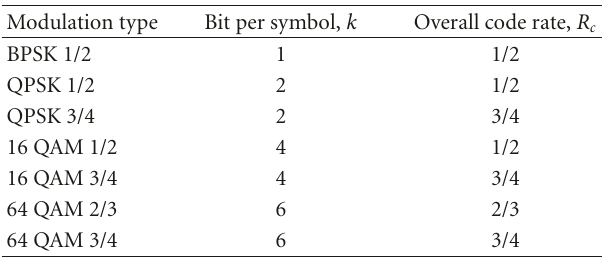
Table 4: Bit per symbol and overall code